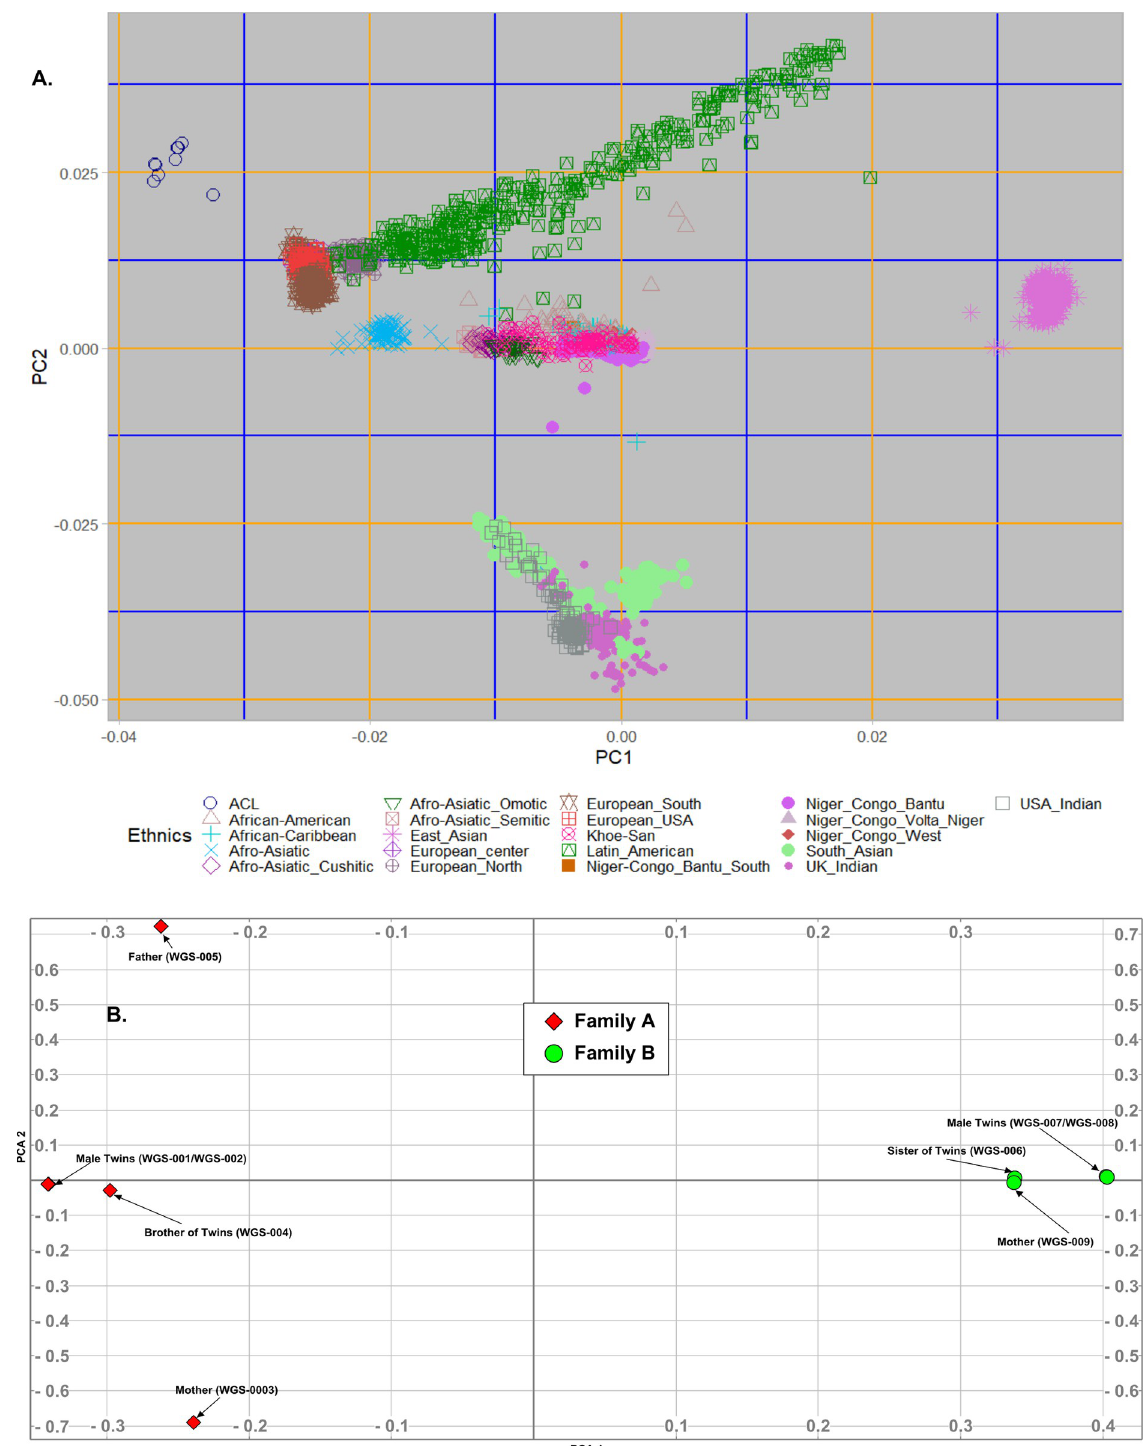
Fig 2. Principal component analysis on merged data sets of Family A and B. Family A is depicted in red diamonds, with Family B in green circles.